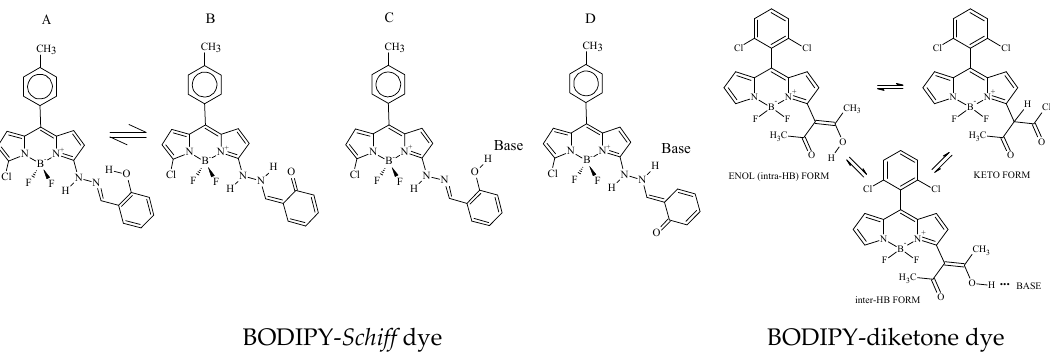
Figure 19. The schemes of equilibria in the fluorescent BODIPY- Schiff and BODIPY-diketone dyes. The fluorescent BODIPY- Schiff and BODIPY-diketone dyes were studied in a wide range of solvent polarities in electronic ground and excited states [87,88]. The effects of the solvent polarity and specific interactions on the keto-enol equilibrium, isomerization of the imine bond, and intramolecular versus intermolecular hydrogen bond equilibrium on the spectroscopic characteristics of the BODIPY-chromophore were investigated. Spectroscopic studies of the dyes showed a significant difference in the behavior of the absorption and emission bands in view of the specificity of the interactions. An increase of solvent polarity leads to a bathochromic shift of the absorption band for the BODIPY- Schiff dye, whereas such an increase for the BODIPY-diketone dye causes a hypsochromic shift. The emission bands’ behavior also differs. In the proton-accepting solvents, the emission band is significantly bathochromically shifted for the BODIPY- Schiff dye, whereas for the BODIPY-diketone dye, the emission band is practically not shifted in the polar environment (Figure 20).